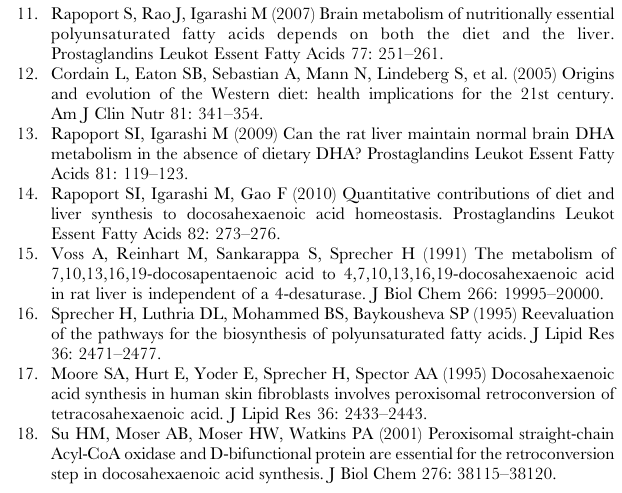
Figure S1 Levels of free DHA (Panel A) and 1-stearoyl-2- docosahexaenoyl-sn-glycero-3-phosphoethanolamine (Panel B) in